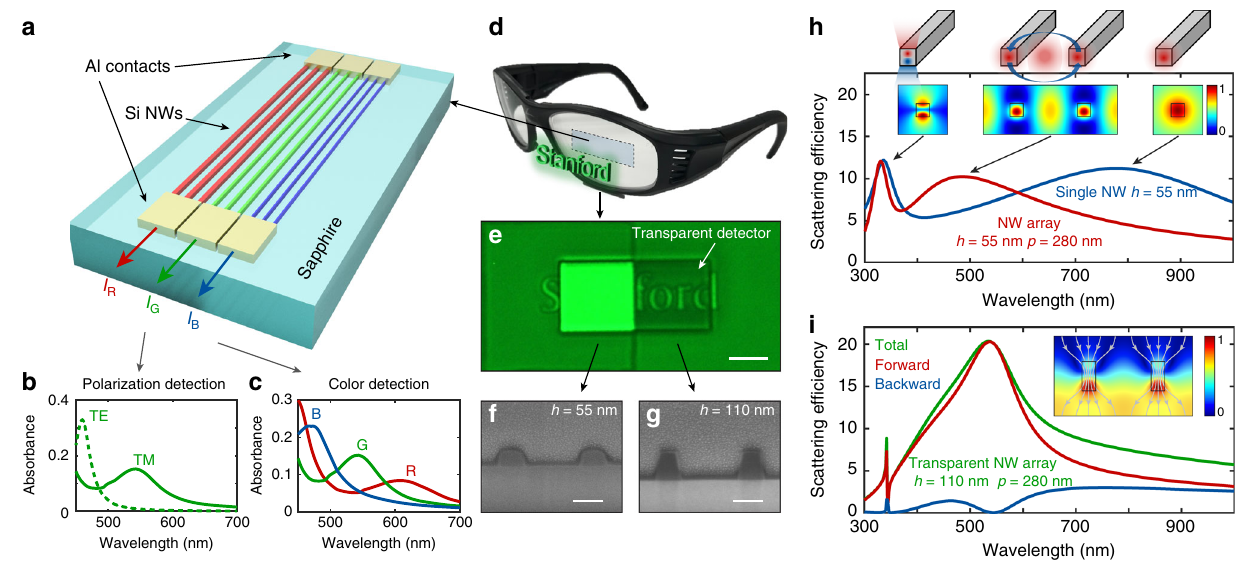
Fig. 1 Transparent multispectral photodetector concept. a A conceptual design of a transparent multispectral photodetector composed of three different single-crystalline Si nanowire (NW) arrays on a sapphire substrate designed to strongly absorb red, green, or blue light. Photo-excited charge carriers are extracted via aluminum contacts. b Simulated absorbance spectra for the “ green ” NW array ( w = 55 nm, h = 110 nm, p = 280 nm) for TM and TE-polarized illumination. c Simulated absorbance spectra for TM-illumination of NW arrays optimized for red, green, and blue light detection. d Image illustrating the possible application of our proposed detectors onto an optical element, such as a pair of glasses. e Re fl ection images of the word “ Stanford ” placed below square regions with conventional, re fl ective (left), and transparent (right) NW arrays optimized for operation in the green. The images were taken using white, TM-polarized illumination and collected through a green color fi lter with a center wavelength of 550 nm and a 32 nm bandwidth. Scale bar: 25 μ m. f , g Cross-sectional scanning electron microscope (SEM) image of conventional ( f ) and transparent ( g ) NW arrays that are optimized for operation in the green. Scale bar: 100 nm. h Scattering ef fi ciency spectrum for a single square cross-sectional NW (blue, h = w = 55 nm) and its array (red, period p = 280 nm) under TM-polarized illumination. The ef fi ciency is normalized by the physical cross-section of the NWs. Insets: Modulus of scattering electric (cid:1) fi eld distribution ( E sca ; z